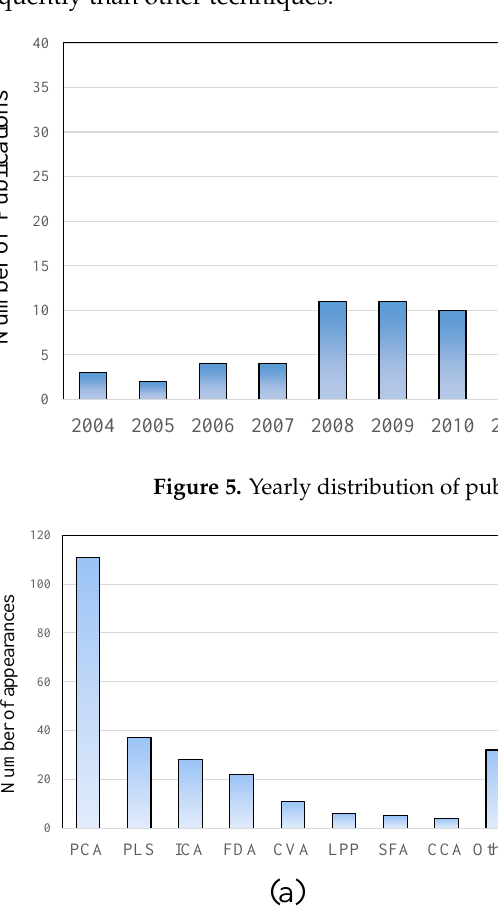
Figure 6. ( a ) Commonly used kernelized methods found in the review; ( b ) Breakdown of the type of case studies found in the